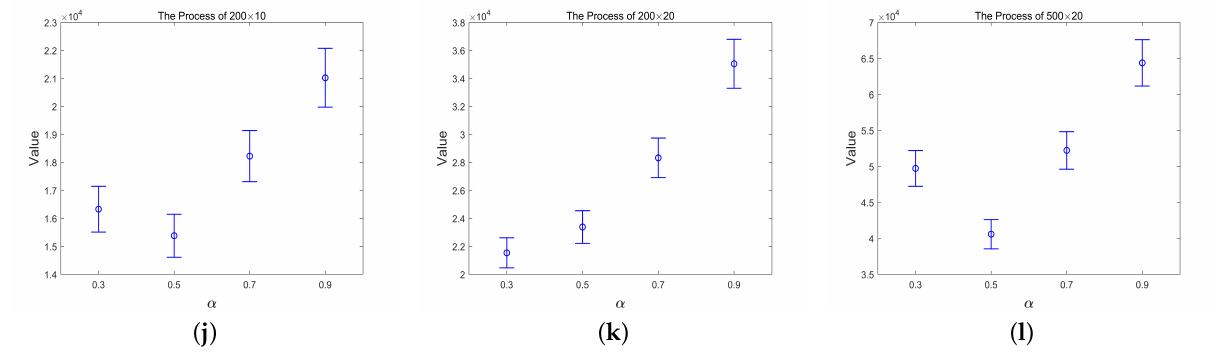
Figure 9. The value under different credibility levels. For small-scale instances ( a – c ), experimental results show that the computational results under different confidence levels have small differences when α < 0.5. For the medium- and large-scale instances ( d – l ), the computational results show that the best solutions of the model under different credibility levels are significantly